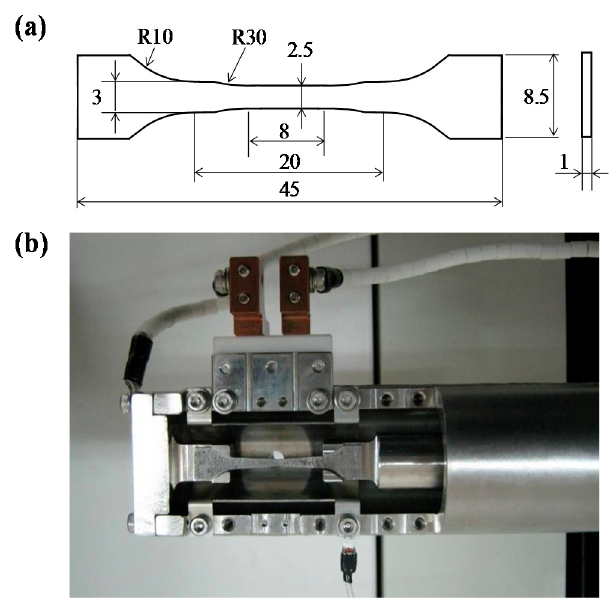
Figure 1. ( a ) The tensile specimen geometry; ( b ) the stage for in situ SEM observation (unit: mm).